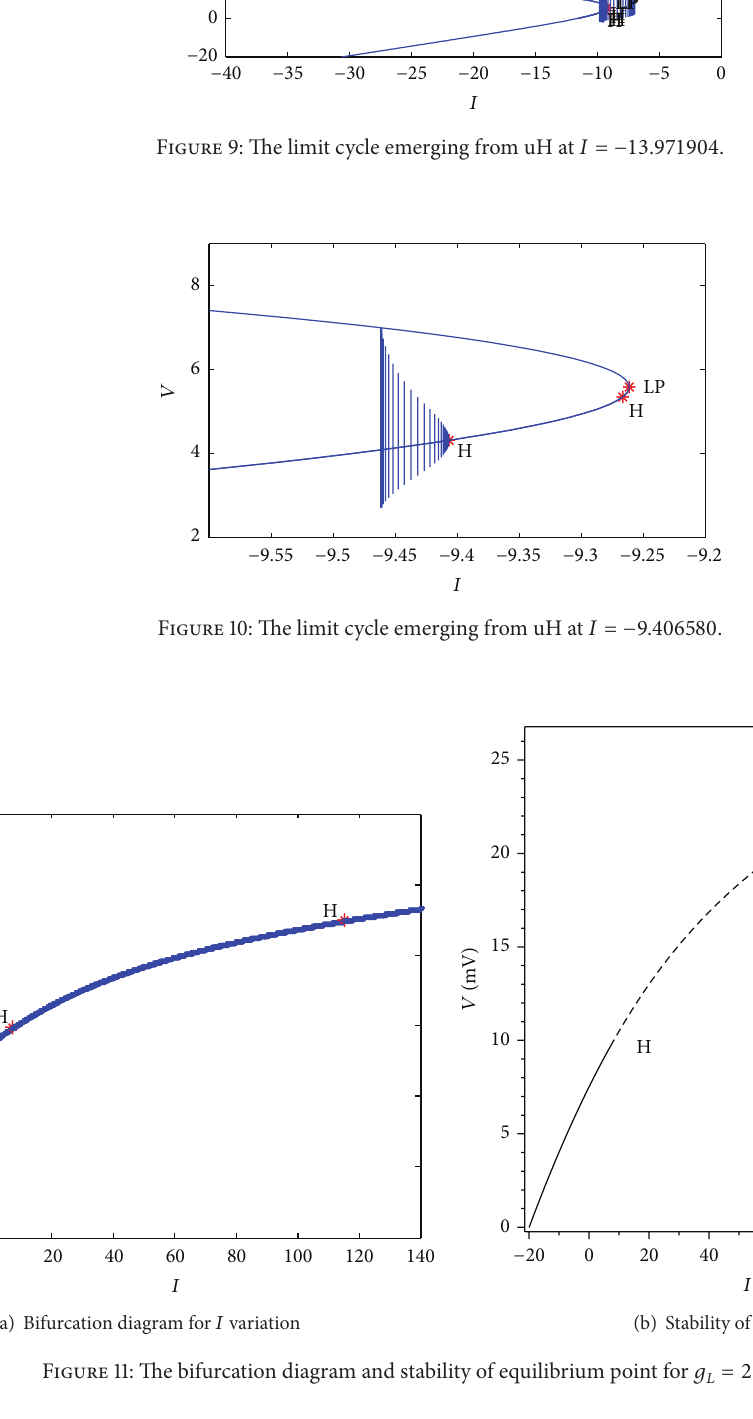
Figure 11: The bifurcation diagram and stability of equilibrium point for 𝑔 𝐿 = 2 , 𝑔